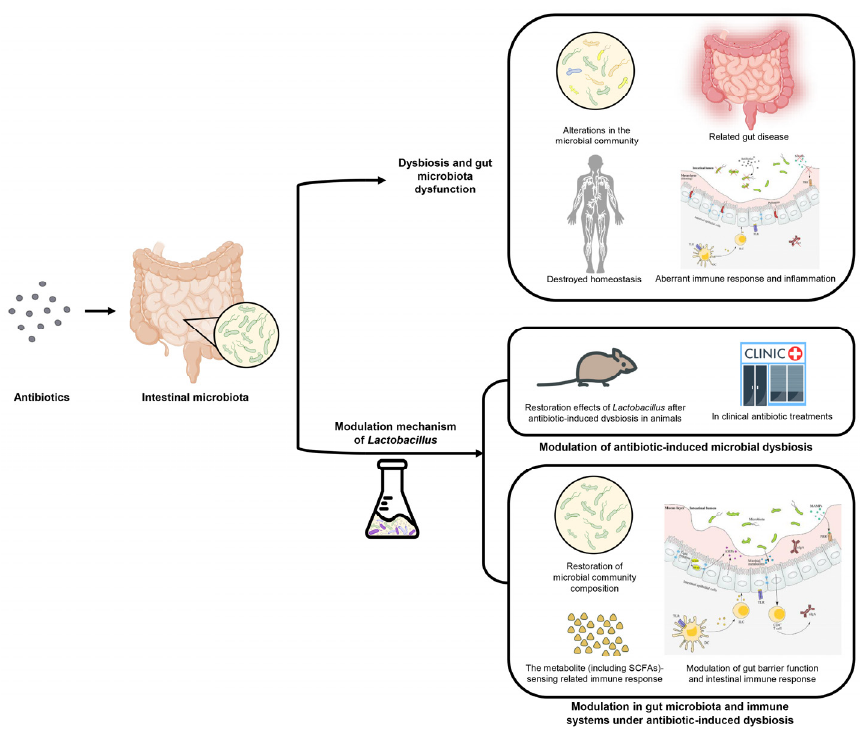
Figure 1. Overview of dysbiosis and dysfunction after antibiotic usage, and modulation mecha- by diverse Lactobacillus nisms by diverse Lactobacillus strains.